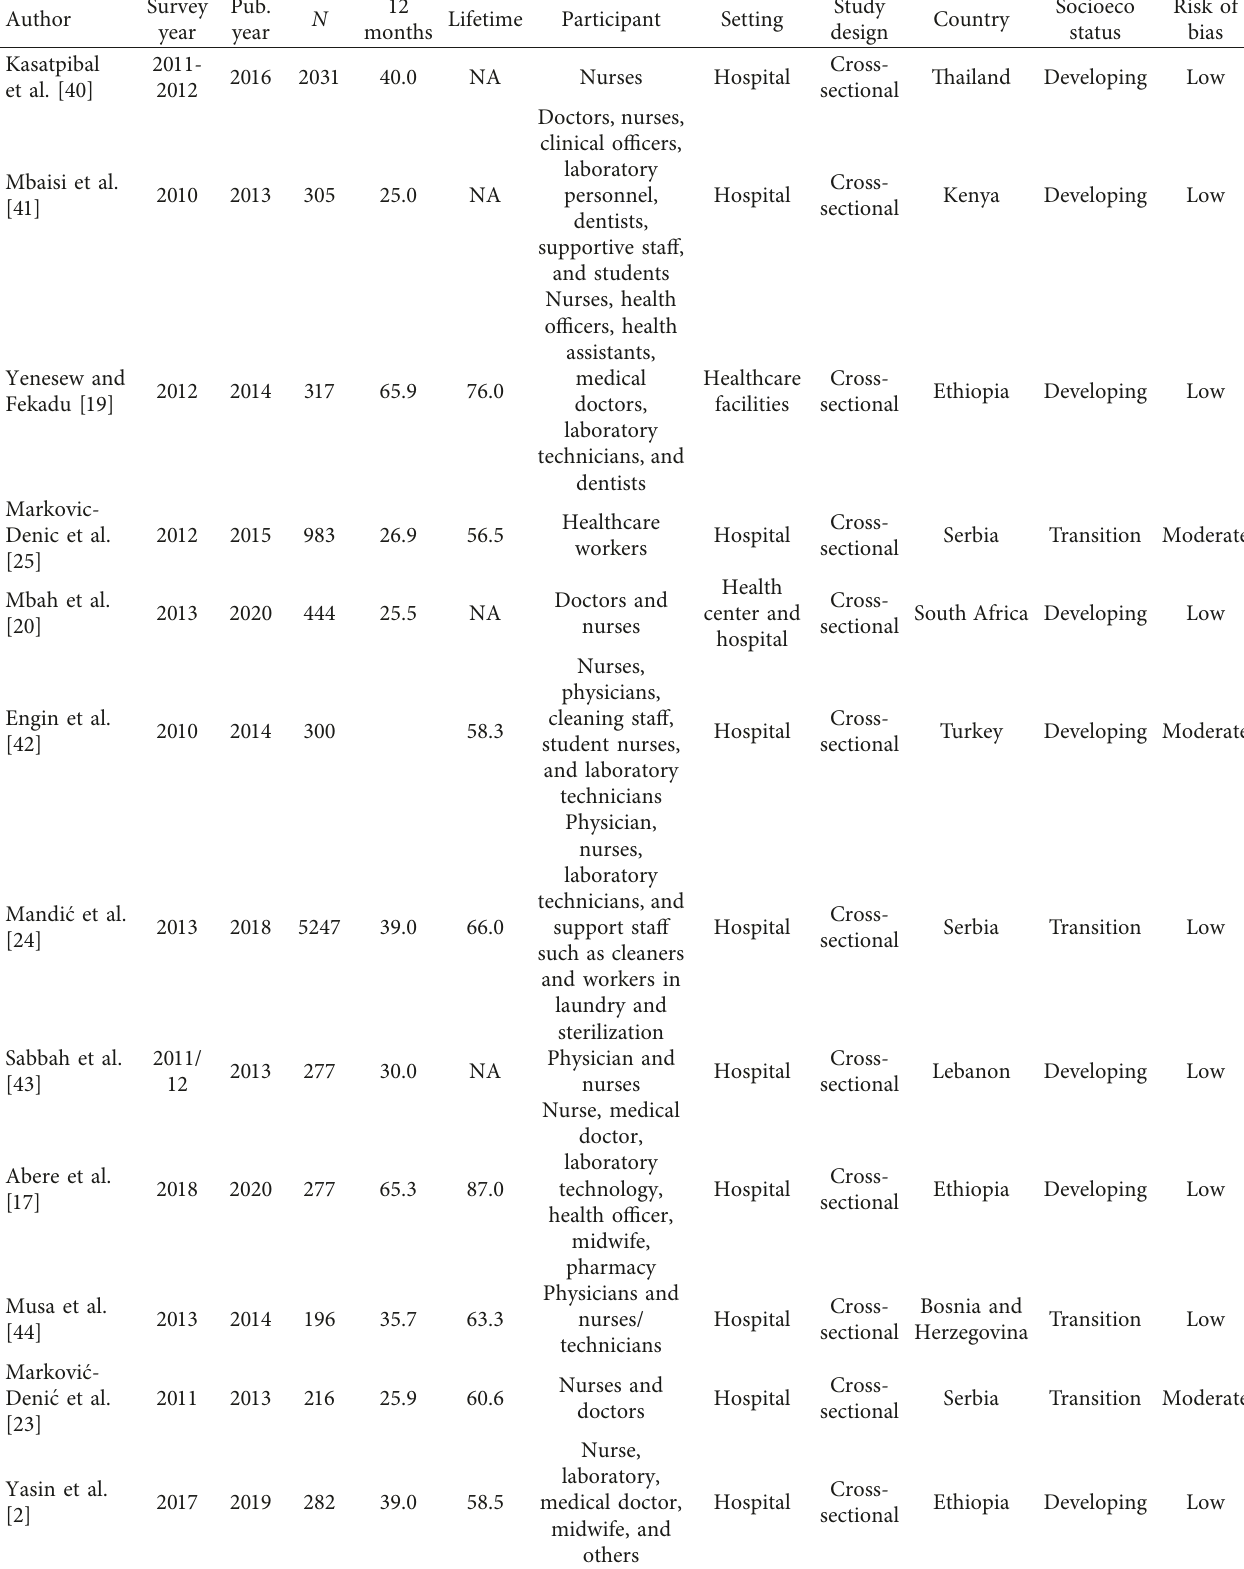
Table 1: Overall characteristics of articles included in the systematic review and meta-analysis,